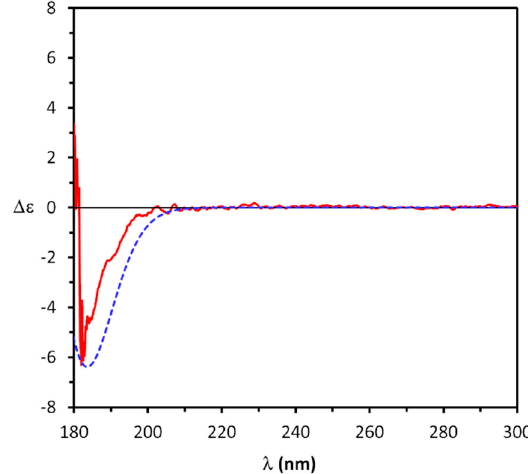
Figure 2. Comparison between experimental ECD spectrum of (-)- 1 (solid red line) and calculated ECD spectrum for (1 S ,2 R ,3 S ,4 R )- 1 (dotted blue line).